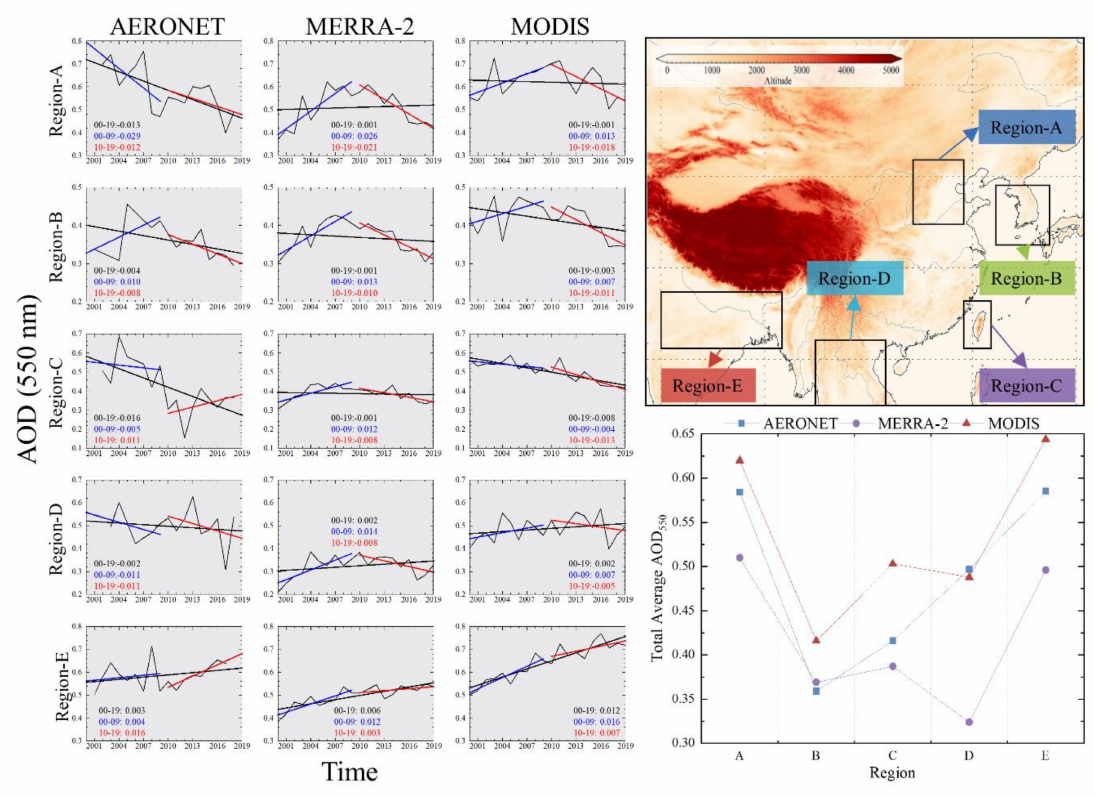
Figure 7. Variation trend of annual AOD using AERONET, MERRA-2, and MODIS datasets over five sub-regions during the study